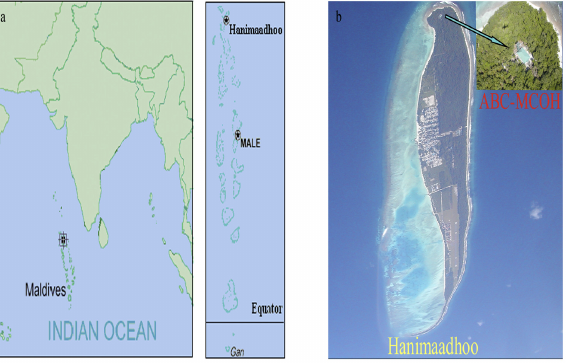
Fig. 1. Location of the Maldives Climate Observatory at Hanimaad- hoo